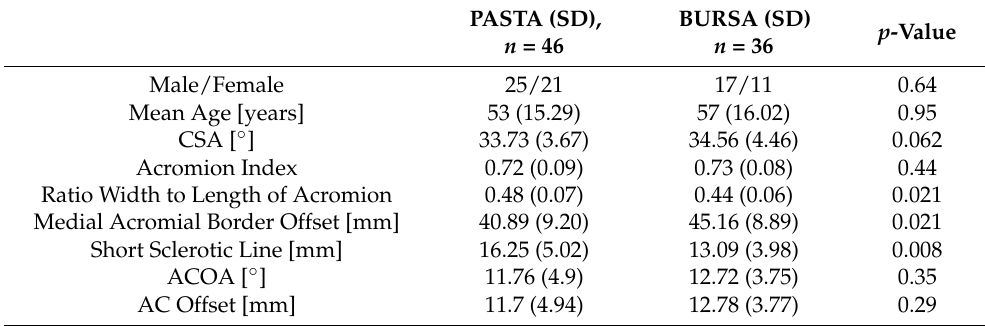
Table 2. Patient demographics and